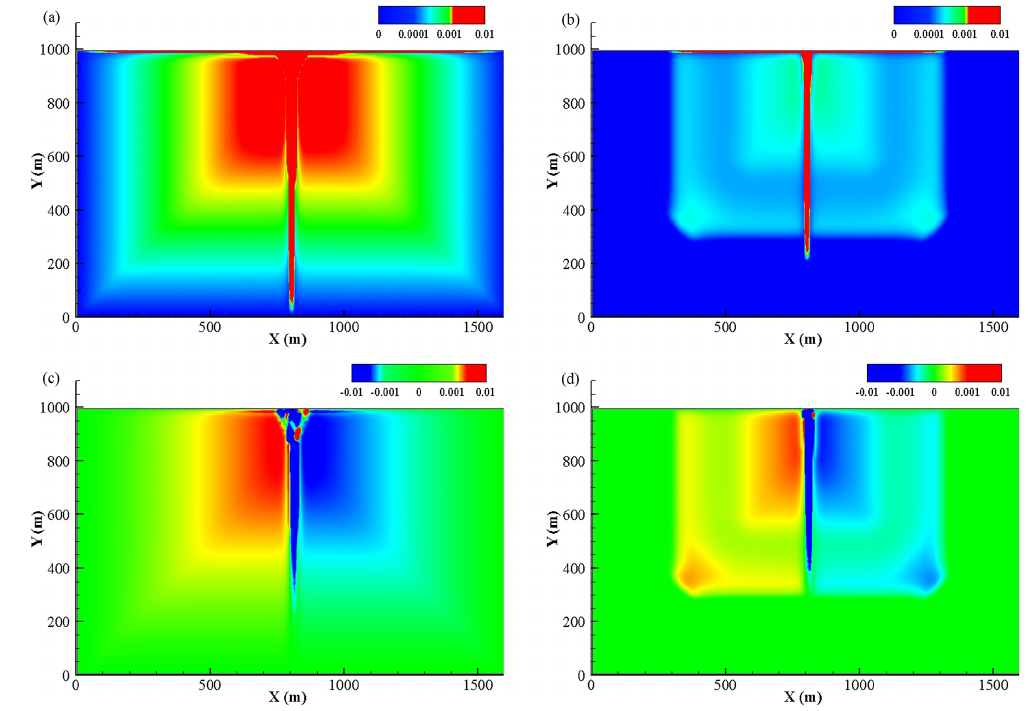
Figure 15. Flux (m 4 s − 2 ) distributions in X and Y direction at 90min (a, c) and 120min (b, d) .